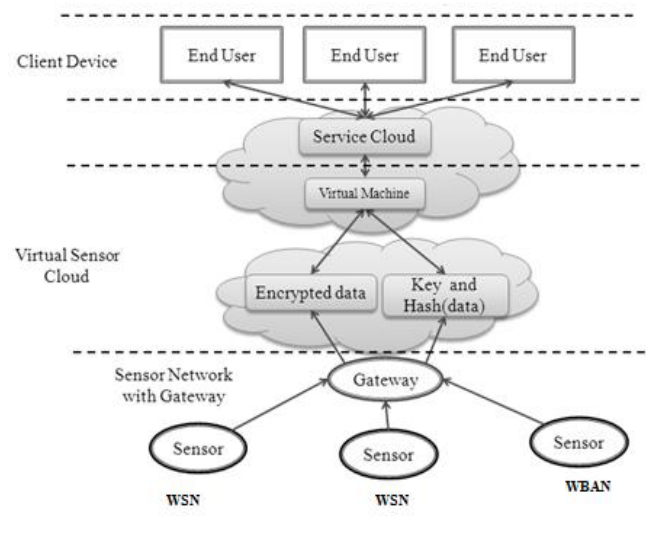
Figure 2. Proposed Sensor Cloud